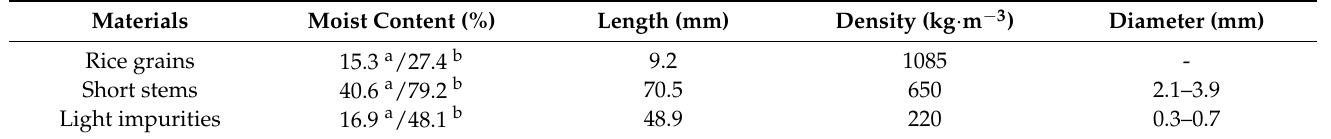
Table 1. Physical properties of rice threshed mixture.